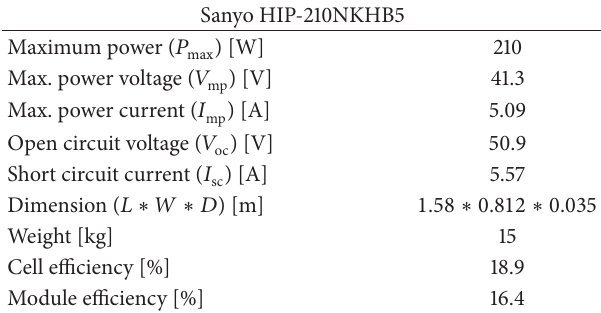
Table 5: Technical characteristics of PV panel.